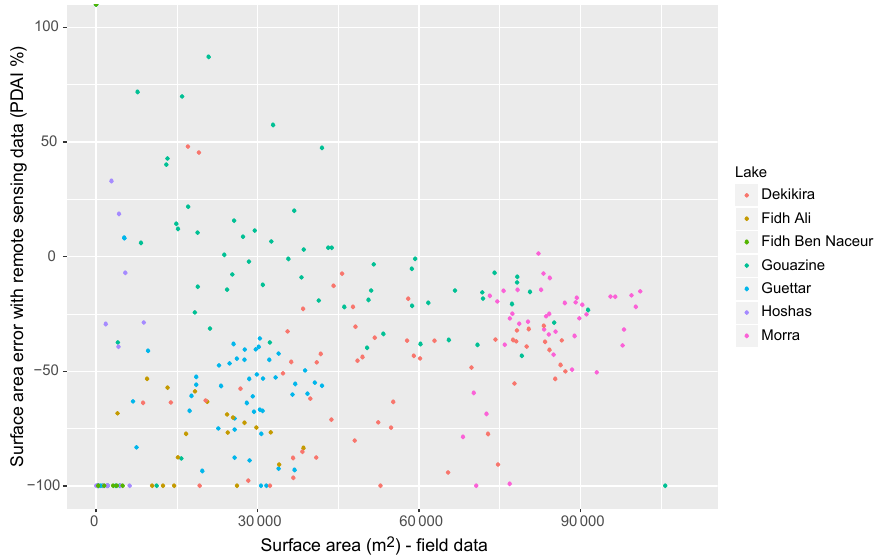
Figure 20. Surface area error (in PDAI%) from global surface water datasets (Pekel et al., 2016) against field data for seven